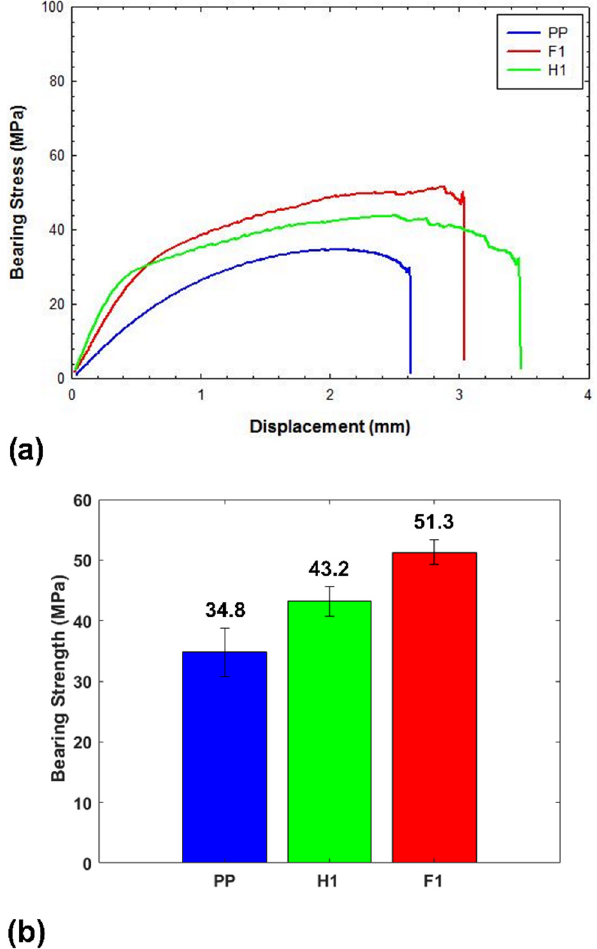
Figure 9. ( a ) Typical bearing stress ‐ displacement curves and ( b ) bearing stress strength for speci ‐ mens with W/D =3.